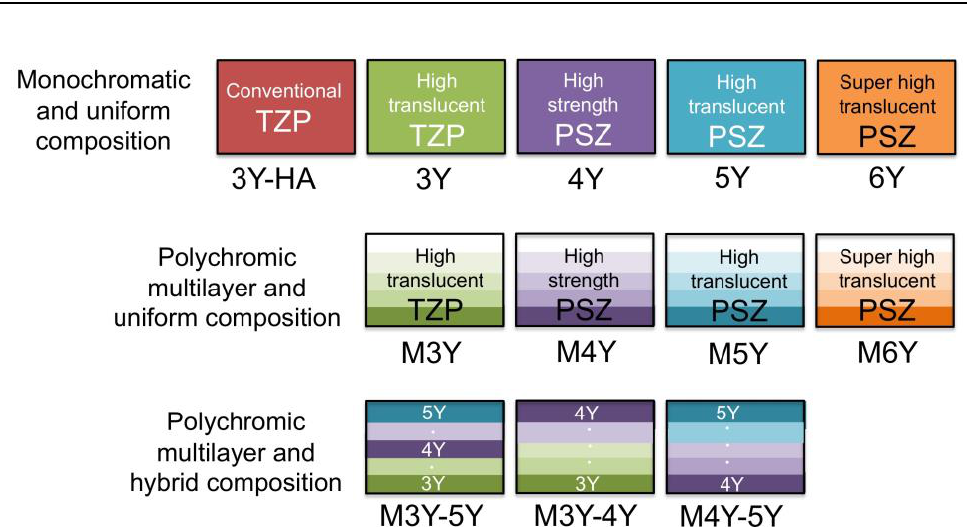
Figure 6. Structural schematic diagram and classification of yttria-stabilized dental zirconia.